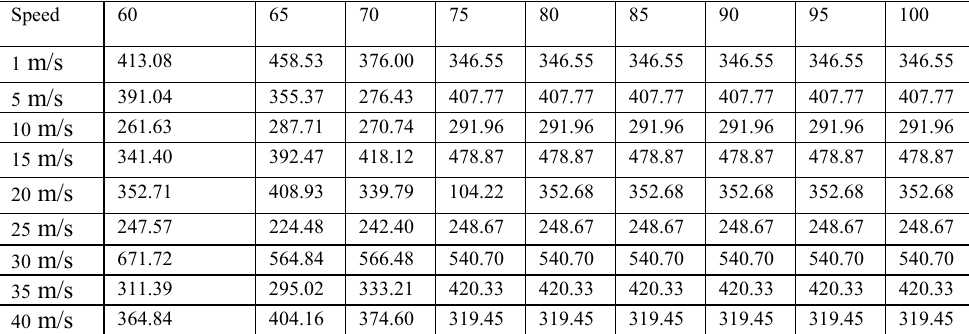
Table 1. Aggregate throughput for TCP.